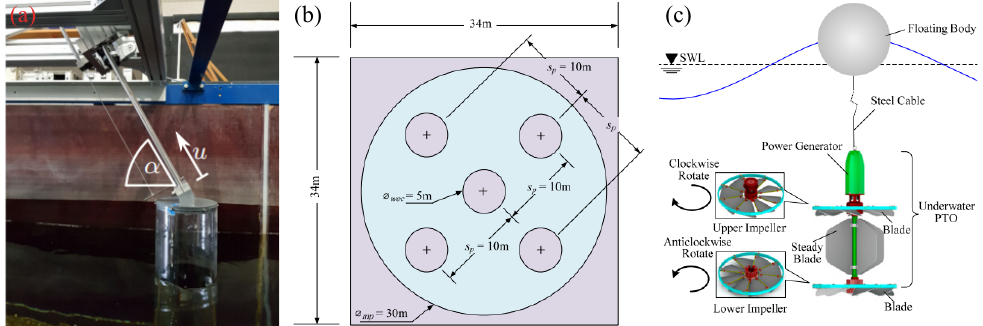
Figure 19. Some novel point absorber concepts, with a guided inclined PA [215], multiple PAs in a moonpool [223] and a novel heaving PA with underwater impeller PTO [224] in ( a – c ),